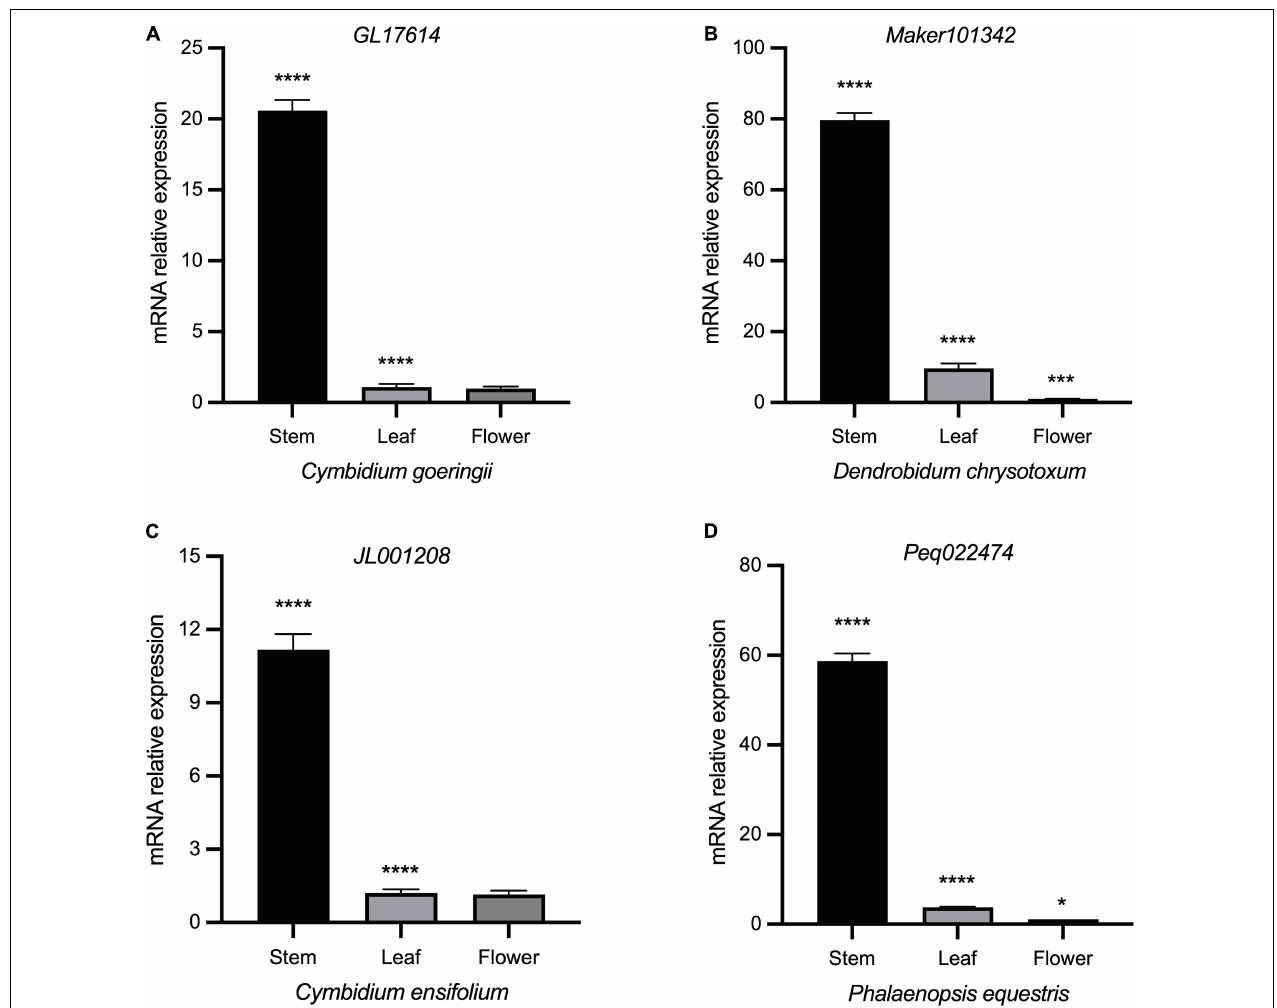
FIGURE 7 | Expression profiles of different tissues of STM homologs in four orchids by RT-qPCR. (A) C. goeringii. (B) D. chrysotoxum. (C) C. ensifolium. (D) P. equestris. ANOVA multiple comparisons were performed with star marks *, ***, and **** representing adjusted p < 0.05, p < 0.001, and p < 0.0001, respectively ( Supplementary Table 6